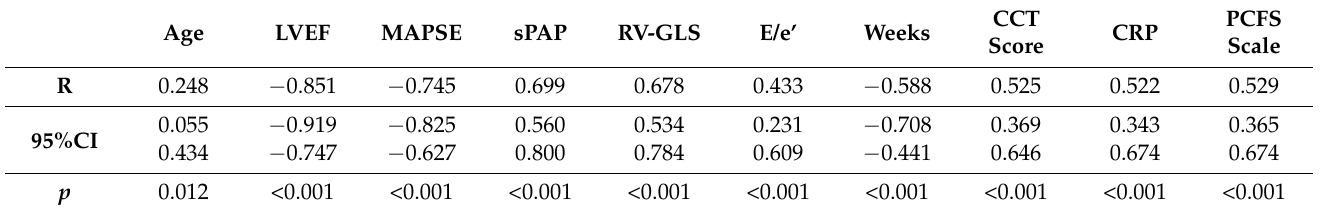
Table 3. Correlations between LV-GLS, other TTE parameters, and laboratory data in study